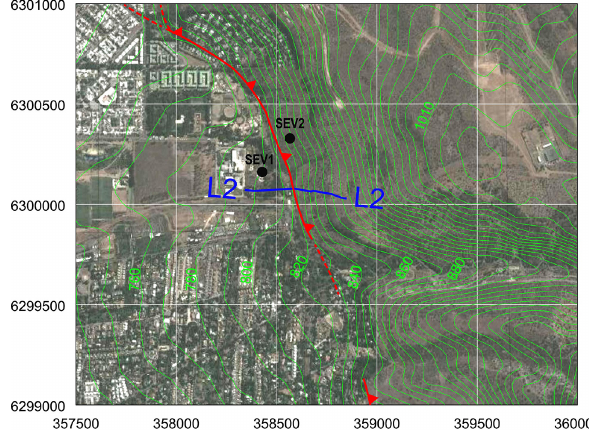
Figure 4. Location of electric profile L2 in the La Reina area. Topo- graphic contour lines (green lines) are based on SRTM data. Points marked as SEV1 and SEV2 are two vertical electric soundings mea- sured on the eastern and western sides of the SRF scarp observed in the area. Red line represents the approximate location of the SRF at the surface according Armijo et al. (2010). Coordinate system: UTM zone 19S,